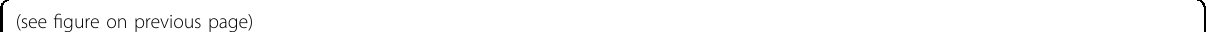
Fig. 3 Experimental results of multifunctional meta-optics devised by a multilayer approach (a – f) and a multi-perturbation approach (g – n). a Schematic illustrating the multilayer approach with a cylindrical lens with NA = 0.1 made from the meta-unit library in Fig. S6 as the converging element and the radial lens from Fig. 2 as the diverging element. Photographs of the diverging ( b ) and converging ( c ) elements of the doublet. SEM images of the diverging ( d ) and converging ( e ) elements. Arrows indicate phase gradient direction. f Measured transverse intensity distributions of transmitted light of converted handedness of the doublet. g Schematic illustrating the multi-perturbation approach for a dual- function cylindrical lens. h Optical image of the device. SEM images of the device at the center ( i ) and corner ( j ) of the device. k Schematic of a meta- unit of the dual-function cylindrical lens. Shown are two sets of apertures (colored red and blue) de fi ned in a silicon thin fi lm A x y . l Simulated transmission spectra of light with converted (red) and preserved (black) handedness. Insets: Out-of-plane component of electric fi eld for the two modes. m Geometric phases of both modes as a function of in-plane rotation angle of the blue (top) and red (bottom) perturbations, respectively. n Measured transverse intensity distributions of handedness converted light on the focal plane of the dual-function cylindrical lens.